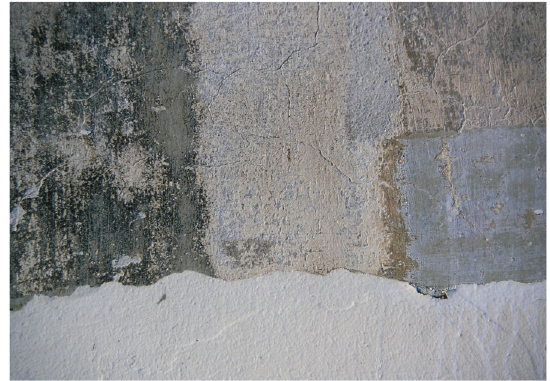
Fig. 13 Walter Gropius, Dessau, Bauhaus, Prellerhaus, 1926, east facade, detail, samples for the removal of later coatings; on the smoothed reddish-yellowish plaster (early shrinkage cracks!) lies a thin lime wash of the same colour, probably dyed with silicate sand fines. The surface is patinated and also sulfated (Source: Analysis Nils Mainusch, HAWK / Hildesheim, 2000)